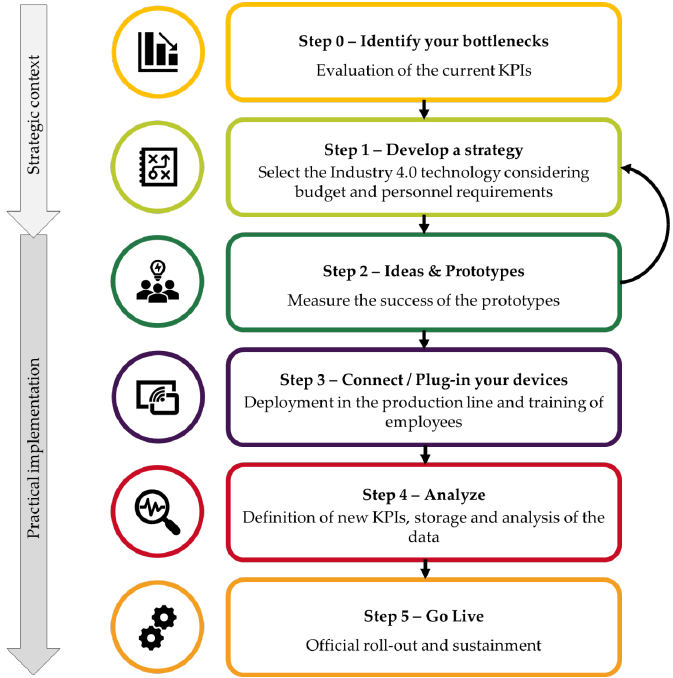
Figure 4. Roadmap for the Fourth Industrial Revolution for SMEs. KPIs: Key Performance Indicators.